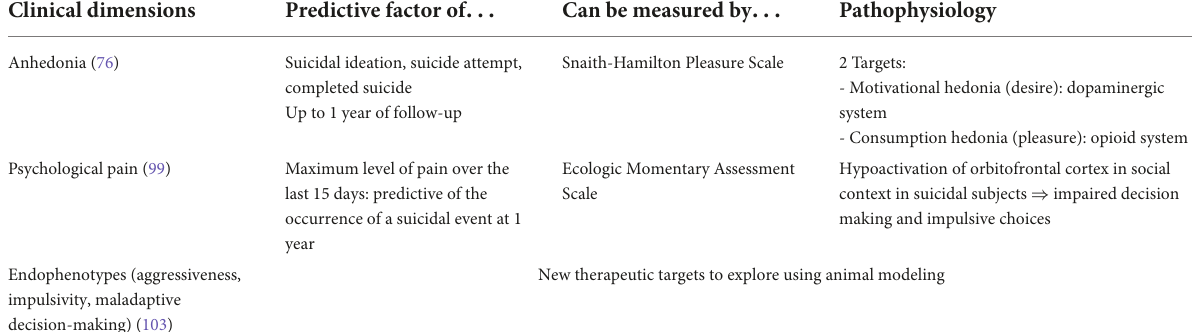
TABLE 1 Clinical dimensions. Clinical dimensions Predictive factor of . .. Can be measured by .